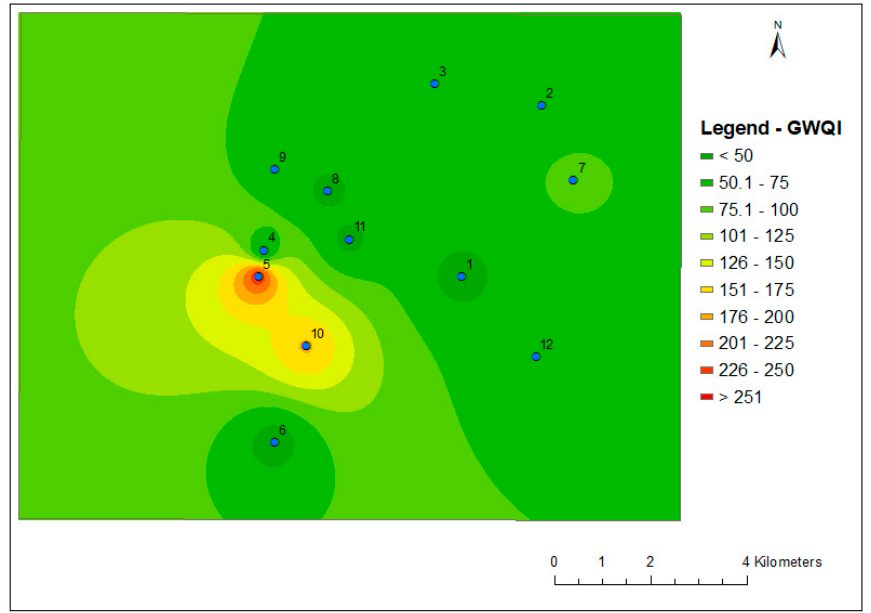
Figure 9. Spatial distribution of groundwater quality index (GWQI) using IDW interpolation in the study area.